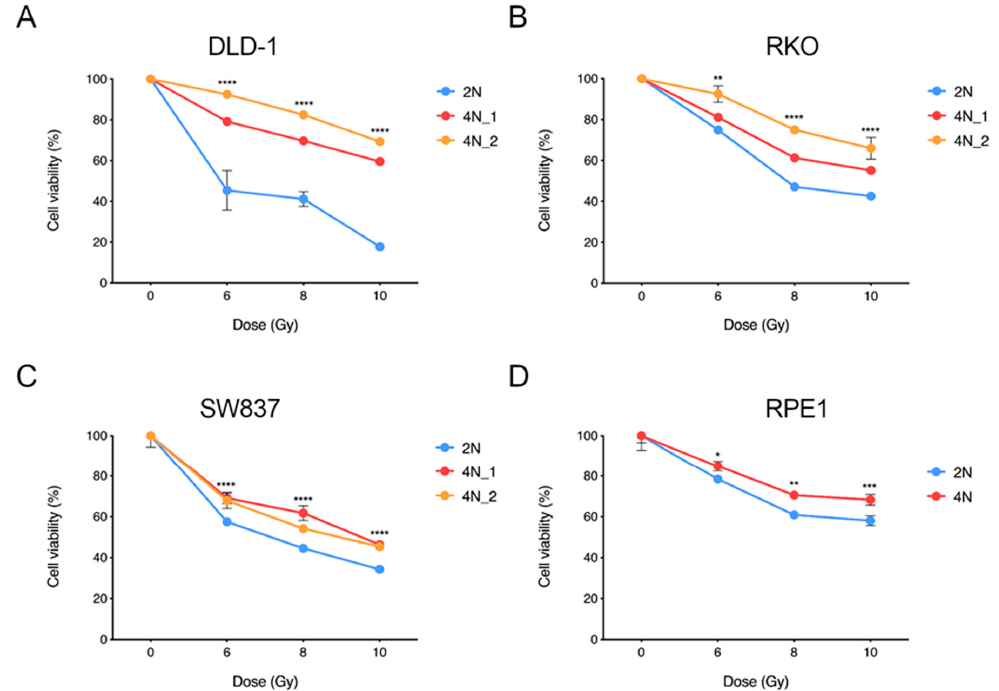
Figure 5. Cellular viability response upon increasing doses of ionizing radiation. Graphs depicting cellular viability curves of one 2N clone and two 4N clones of CRC cells ( A ) DLD-1, ( B ) RKO, ( C ) SW837 and ( D ) the non-transformed cell line RPE1 in response to irradiation at the indicated doses. Each cellular viability was normalized based on its corresponding non-irradiated counterpart. Fitted curves for two replicates from three independent experiments are plotted. ANOVA test with post-hoc Tukey was performed to test significance. Data are reported as means ± SD. *, p < 0.05; **, p < 0.01; ***, p < 0.001; ****, p < 0.0001.